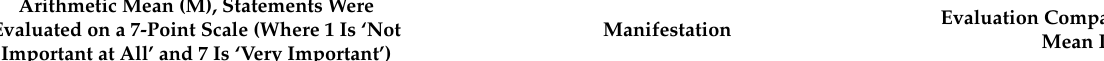
Table 4. Variations of employers’ and employees’ opinions regarding critical thinking in professional activities/evaluation comparison by